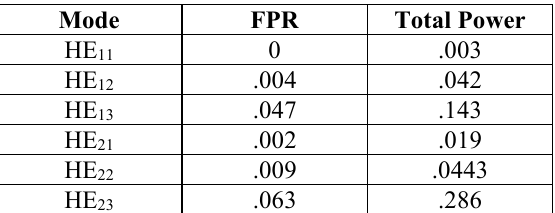
Table 1. Fractional Reflection for non-HE11 modes